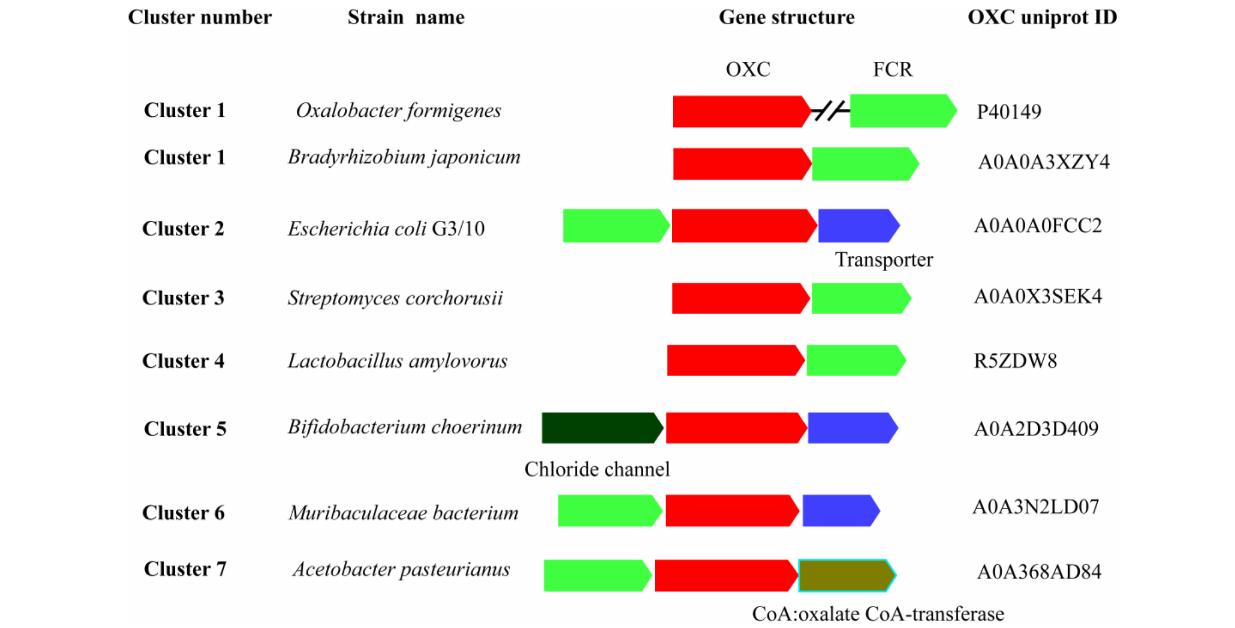
FIGURE 2 | Schematic view of the genomic context of oxalyl-coenzyme A decarboxylase (OXC). The bacteria of the OXCs are listed on the left. The UniProt IDs of the OXCs are listed on the right. The S OXCs or FCR are shown in red and blue color, respectively. The annotated names of other genes are shown by different color and shown under the